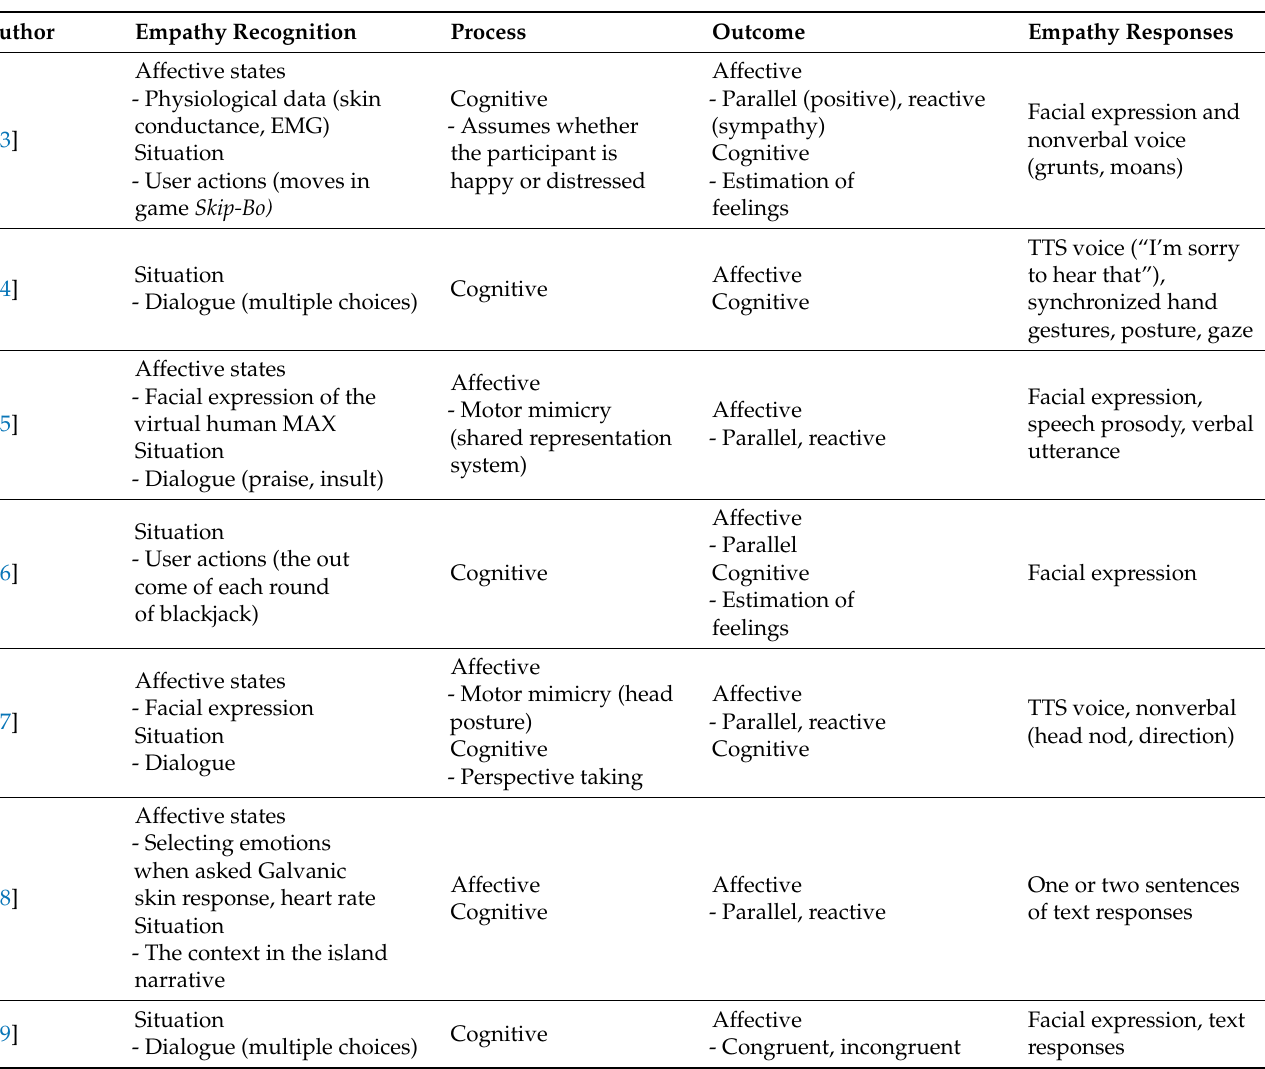
Table 4. Empathic recognition and responses of virtual agent